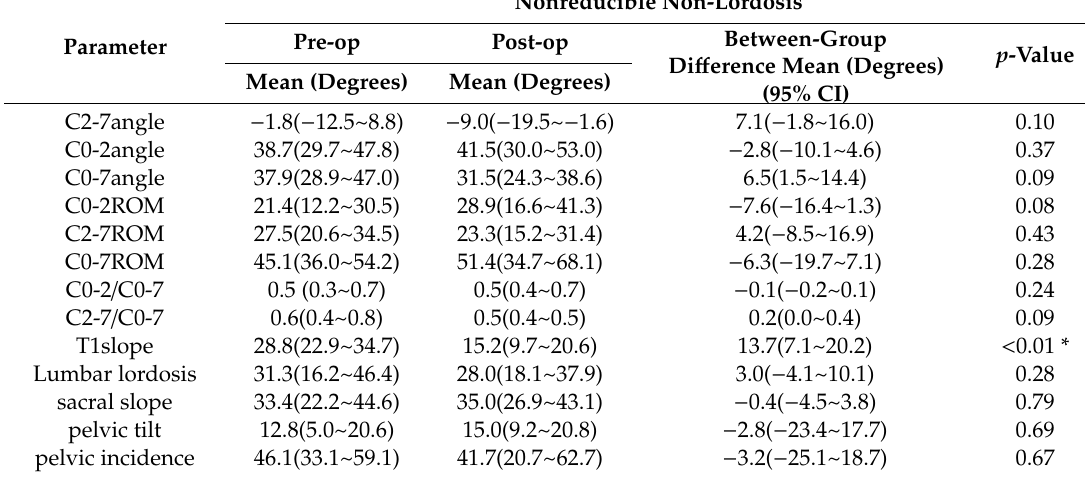
Table 8. Comparison of pre-operative vs. post-operative radiological parameters of the non-reducible non-lordosis group.